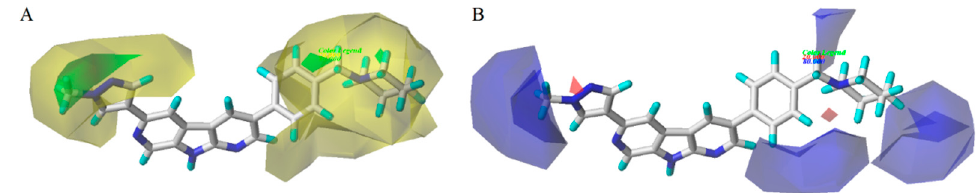
Figure 4. Steric ( A ) and electrostatic ( B ) contours of the CoMFA model. The green color shows the favored steric area and the yellow color show steric area. The red color shows the favored negative electrostatic area and the blue color shows the favored positive electrostatic area.